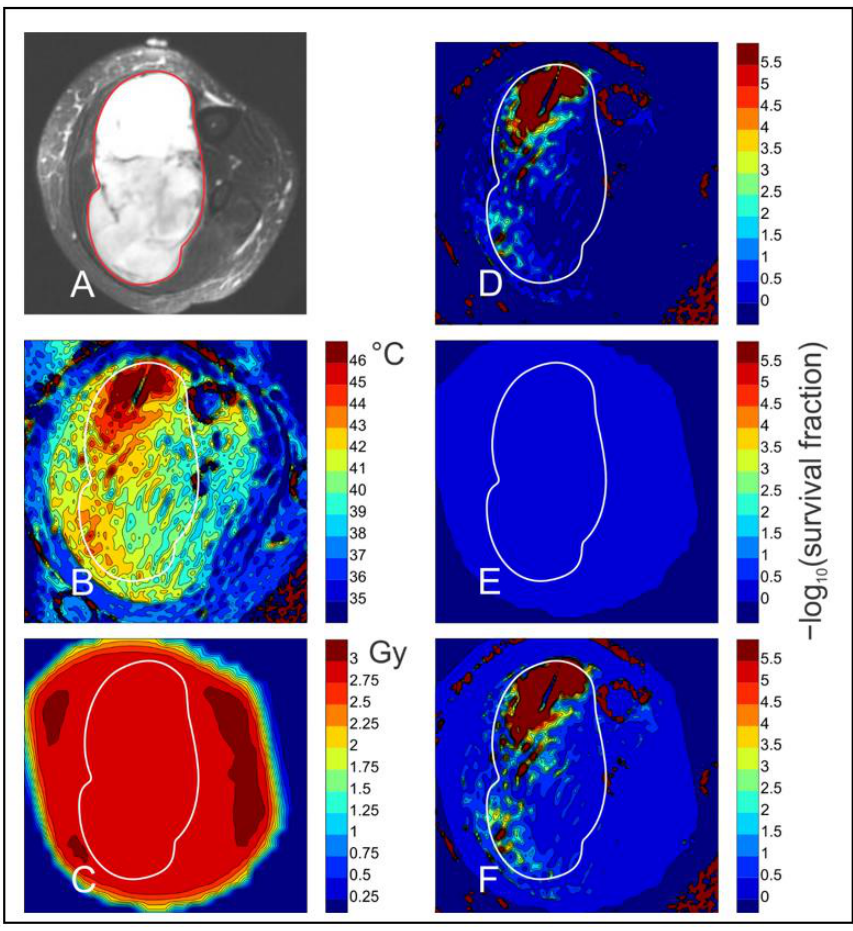
Figure 4. Imaging and simulation of combined HT and radiation treatment of a sarcoma. Images show a cross-section through a human patient’s calf. Simulations are based on results of Loshek et al. [139] for dependence of survival fraction of Chinese hamster ovary cells on doses of combined radiation and heating, together with results of Sapareto and Dewey [61] for the dependence of thermal dose on temperature. The period of heating was 54 min. Details of the simulation are provided in Text S1. ( A ) Diffusion weighted MRI image of thigh cross-section. Tumor region is outlined in red and transferred to other images. ( B ) Temperature distribution in tissue during hyperthermia, obtained by non-invasive MRI thermometry. ( C )Radiation dose derived from treatment plan. ( D ) Predicted cell kill from HT alone. All cell kill values are expressed in terms of − log10 (survival fraction). ( E ) Predicted cell kill from radiation alone. ( F ) Predicted cell kill from combined HT and radiation. The impact of the varied temperature distribution on cell killing (as depicted by − log10 (survival)) shows highly efficient killing in the hottest tumor regions, along with virtually no killing in the cooler regions of the tumor (Figure 4D). The influence of